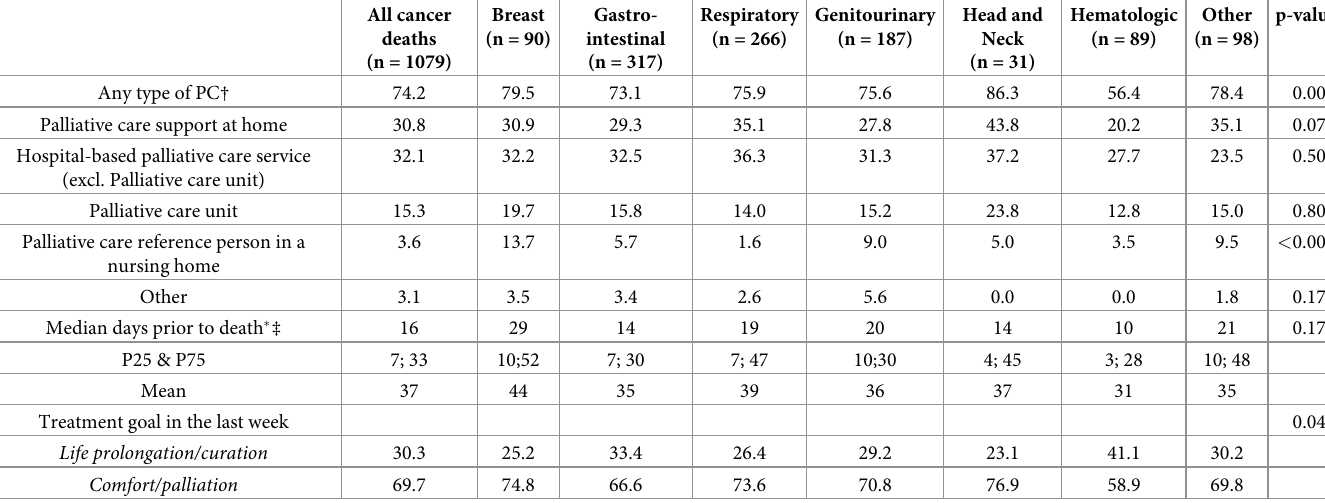
Table 2. Rates, timing of referral to specialist palliative care services and treatment goal in the last week of life; % of non-sudden deaths.